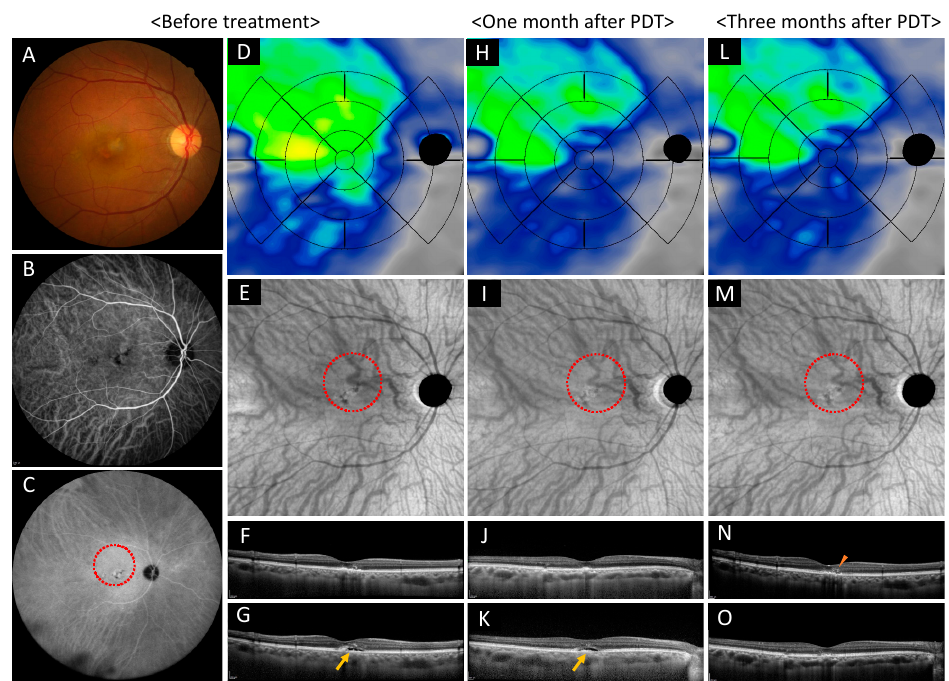
Figure 6. Images of the right eye of a 53-year-old male with chronic central serous chorioretinopathy. ( A – G ) Show before treatment, ( H – K ) show one month after photodynamic therapy (PDT), and ( L – O ) show three months after PDT. ( A ) Color fundus photograph shows the subretinal detachment and the retinal pigment epithelium (RPE) abnormality at the macular area. ( B , C ) Early and late phase of indocyanine green angiography show dilated choroidal vessels, punctate hyperfluorescent spots, and choroidal vascular hyperpermeability. PDT irradiated the area highlighted with red dot circle. ( D ) Choroidal volume color map shows thickened choroid at superior and temporal areas before treatment. ( H ) The choroidal volume decreased at superior, macular, and temporal areas at one month. ( L ) Three months after treatment, choroidal volume showed no change at the superior, macular, and temporal areas. ( E ) En face optical coherence tomography images show dilated choroidal vessels and dilated abnormal anastomosed vessels crossed superior and inferior area. ( I ) Constriction of the choroidal blood vessels was observed one month after treatment. ( M ) Three months after treatment, constriction of choroidal blood vessels was still observed. ( F , J , N ) are vertical scans and ( G , K , O ) are horizontal scans through central fovea. ( F , G ) Show shallow subretinal detachment before treatment (show arrow). ( J , K ) Shallow retinal detachment still exists one month after the treatment (show arrow). ( N , O ) Serous retinal detachment resolved completely at three months after the treatment, remained RPE undulation and intraretinal hyperreflective materials (show arrowhead).